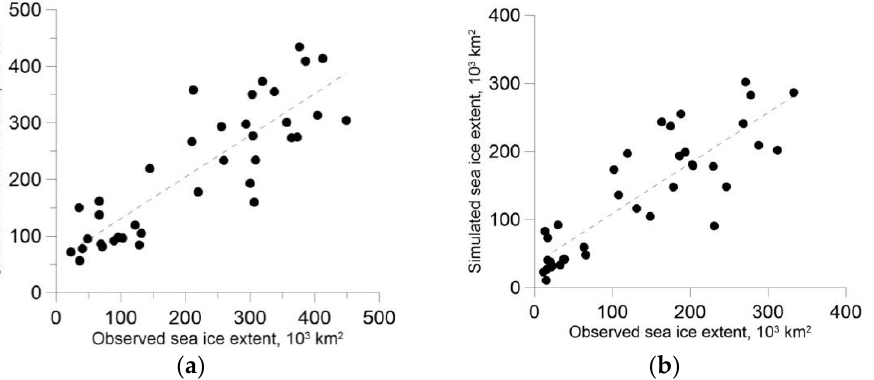
Figure 6. Comparing of simulated and observed sea ice extent in the Kara Sea in August ( a ) and in September ( b ) for